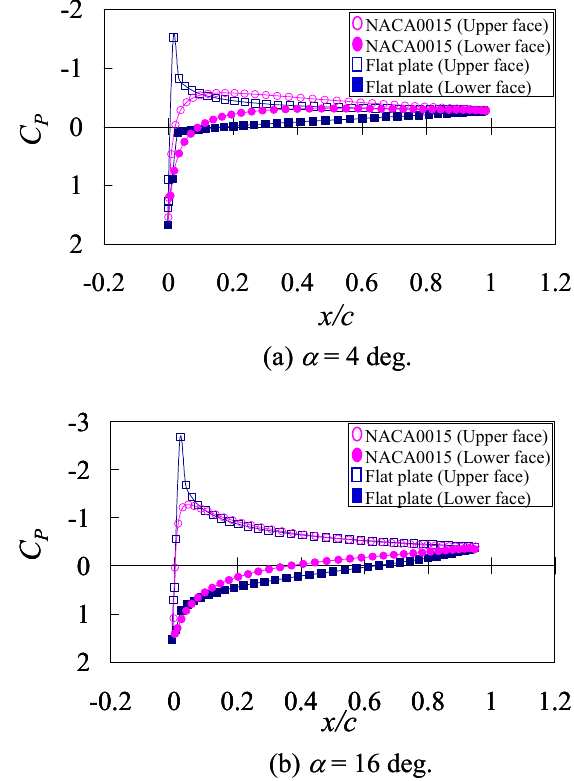
(b) α = 16 Fig. 10 Surface-pressure profiles on airfoil surfaces at Re = 1.0×10 2 (NACA0015 and flat plate).